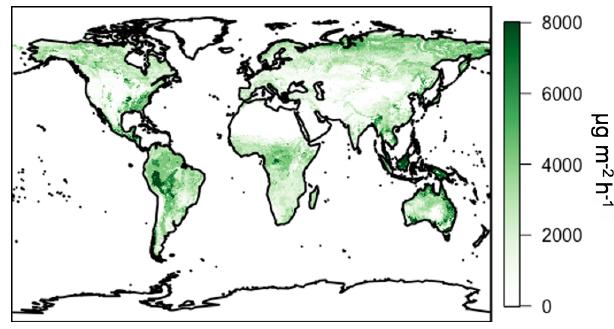
Figure 8. Base isoprene emission factors used in this work.